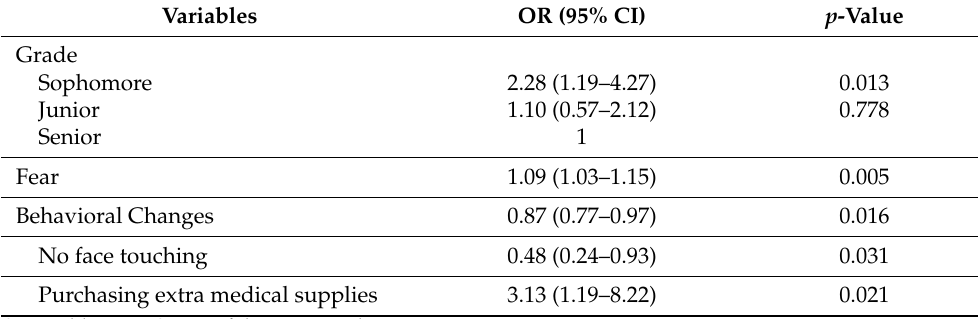
Table 4. Associations of grade, fear, and behavioral changes with the depressed